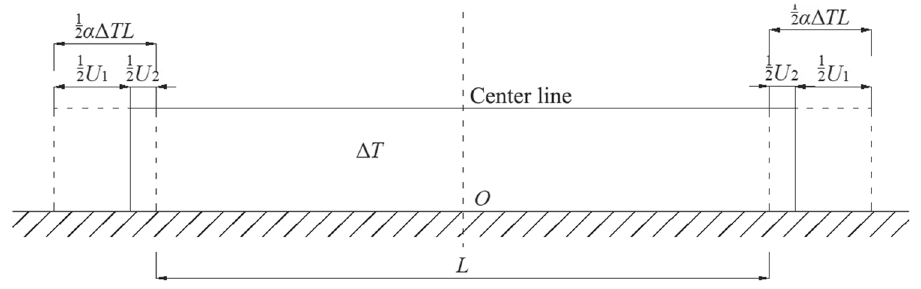
Figure 2. Schematic representation of the continuous elastic